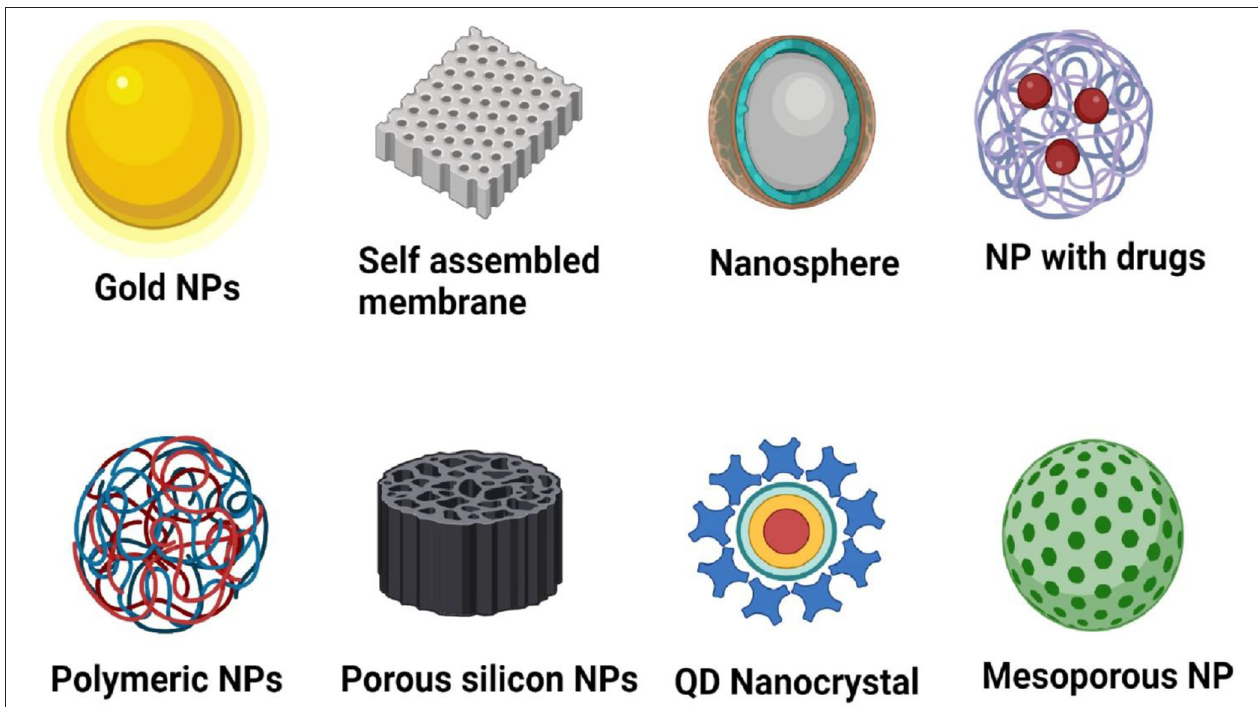
FIGURE 2 | Different types of nanoparticles used in biomedicine for therapeutics of viral diseases. NP, Nanoparticles created with